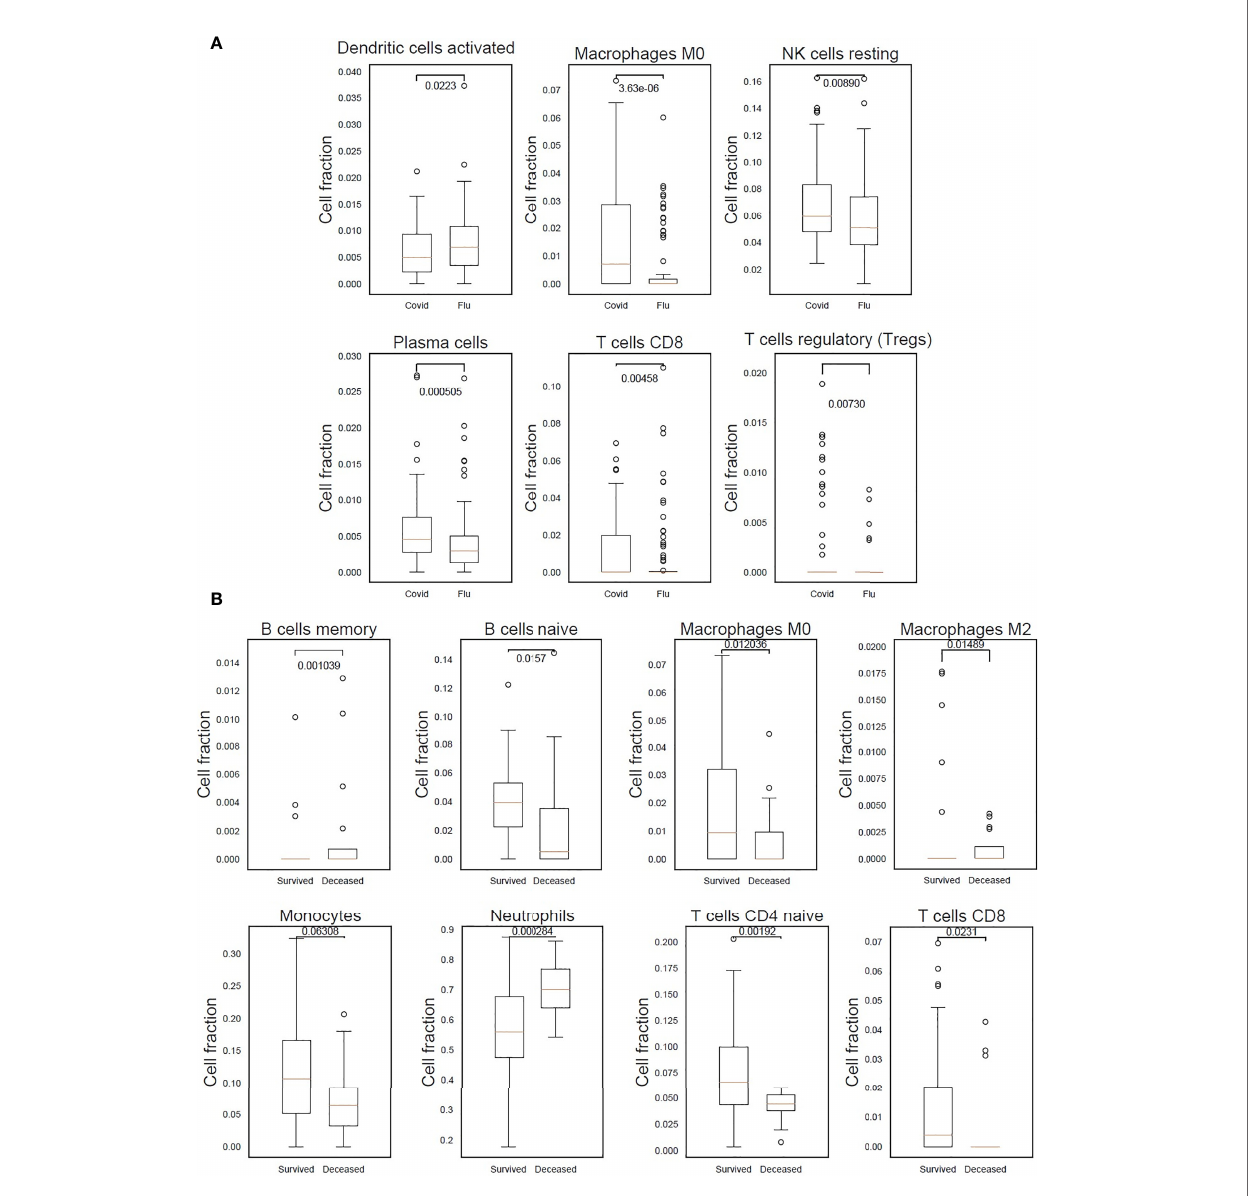
FIGURE 2 | Differences in immune response indicated by predicted cell types in patients with COVID-19, who either survived or died, and patients with in fl uenza. (A) M0 macrophages, resting natural killer (NK) cells, plasma cells, cytotoxic CD8+ T cells and regulatory T cells were found to be signi fi cantly higher in COVID-19 patients. In in fl uenza patients a signi fi cantly higher proportion of activated dendritic cells was detected. (B) A statistically signi fi cant higher count of neutrophils in COVID-19 patients who died after 30 days indicating the presence of an elevated innate immune response. While an adaptive immune response was detected in COVID-19 survivors as can be seen by the statistically signi fi cant higher count of naïve B cells, and CD4+ and CD8+ T